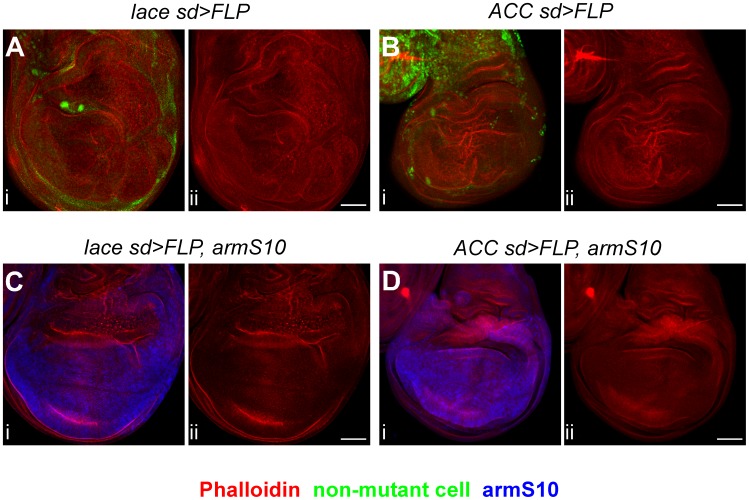
The lace overproliferation phenotype is partially rescued by activated Armadillo.Mutant clones of lace2 (A, C) or ACC1 (B, D) were induced using sd-GAL4; UAS-FLP, and examined for tissue overgrowth in the absence (A, B) or presence (C, D) of a constitutively activated form of Armadillo (armS10), expressed using a UAS-armS10 transgene. For each image pair, panel i shows tissue growth patterns as revealed by Phalloidin (red in A–D), the mutant clone marker (green indicates non-mutant cells in A, B), or armS10 expression (blue in C, D), with the Phalloidin signal alone shown in panel ii. Complete genotypes are listed in Supplemental Table S4. Note that tissue overgrowth in the wing hinge region was not suppressed (C, D) because armS10 is not expressed in the hinge at this stage. Scale bars, 50 µm.